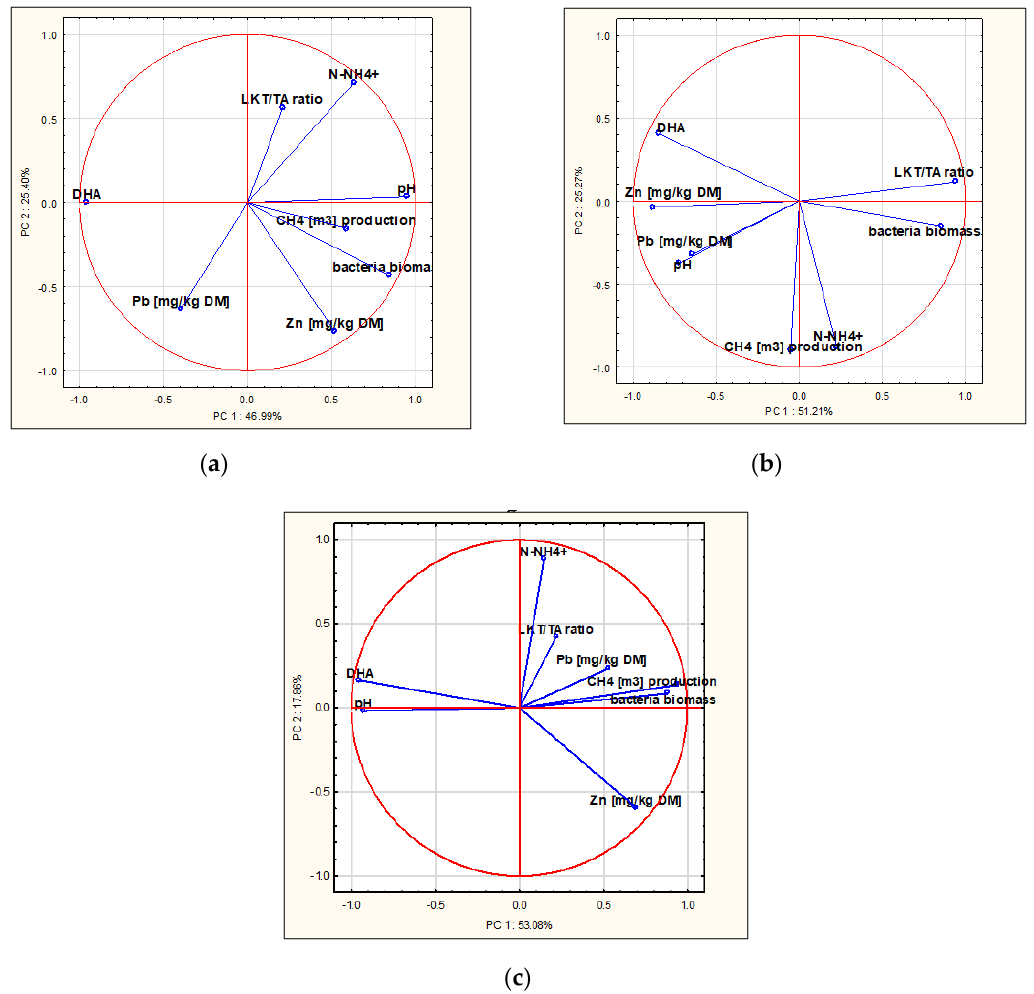
Figure 16. The distribution of bacterial biomass, activity and the chemical properties in the anaerobic digestion in two PCA axes. Legend: ( a )—SS sample, ( b )—SS + kraft lignin sample, ( c )—SS + kraft lignin/silica sample; DHA—dehydrogenase activity, VFA/TA ratio—volatile fatty acids ‐ to ‐ total alkalinity ratio, CH 4 —methane emission, N ‐ NH 4+ —ammonium nitrate, Zn—zinc, Pb—lead.